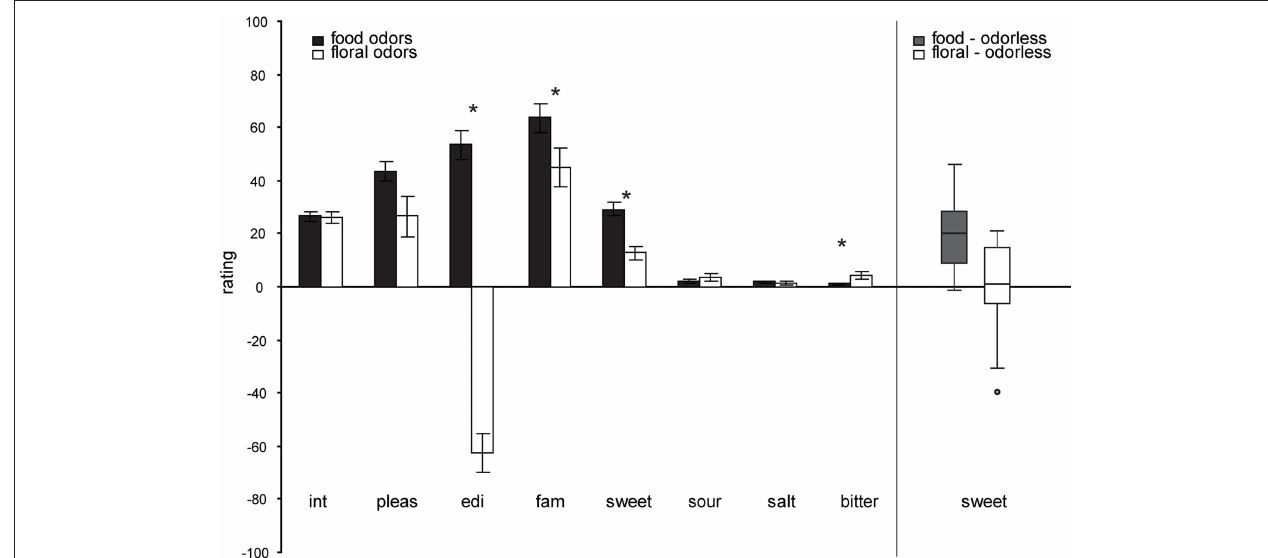
reflect the lowest and highest observation, the upper and lower boundaries of the box represent the upper and lower quartiles, the middle line of the box represents the median and the circle represents a single outlier, that was removed from the correlation analyses). Note that there is similar across-subject variability in food and floral sweetness ratings, as illustrated in right box and whisker